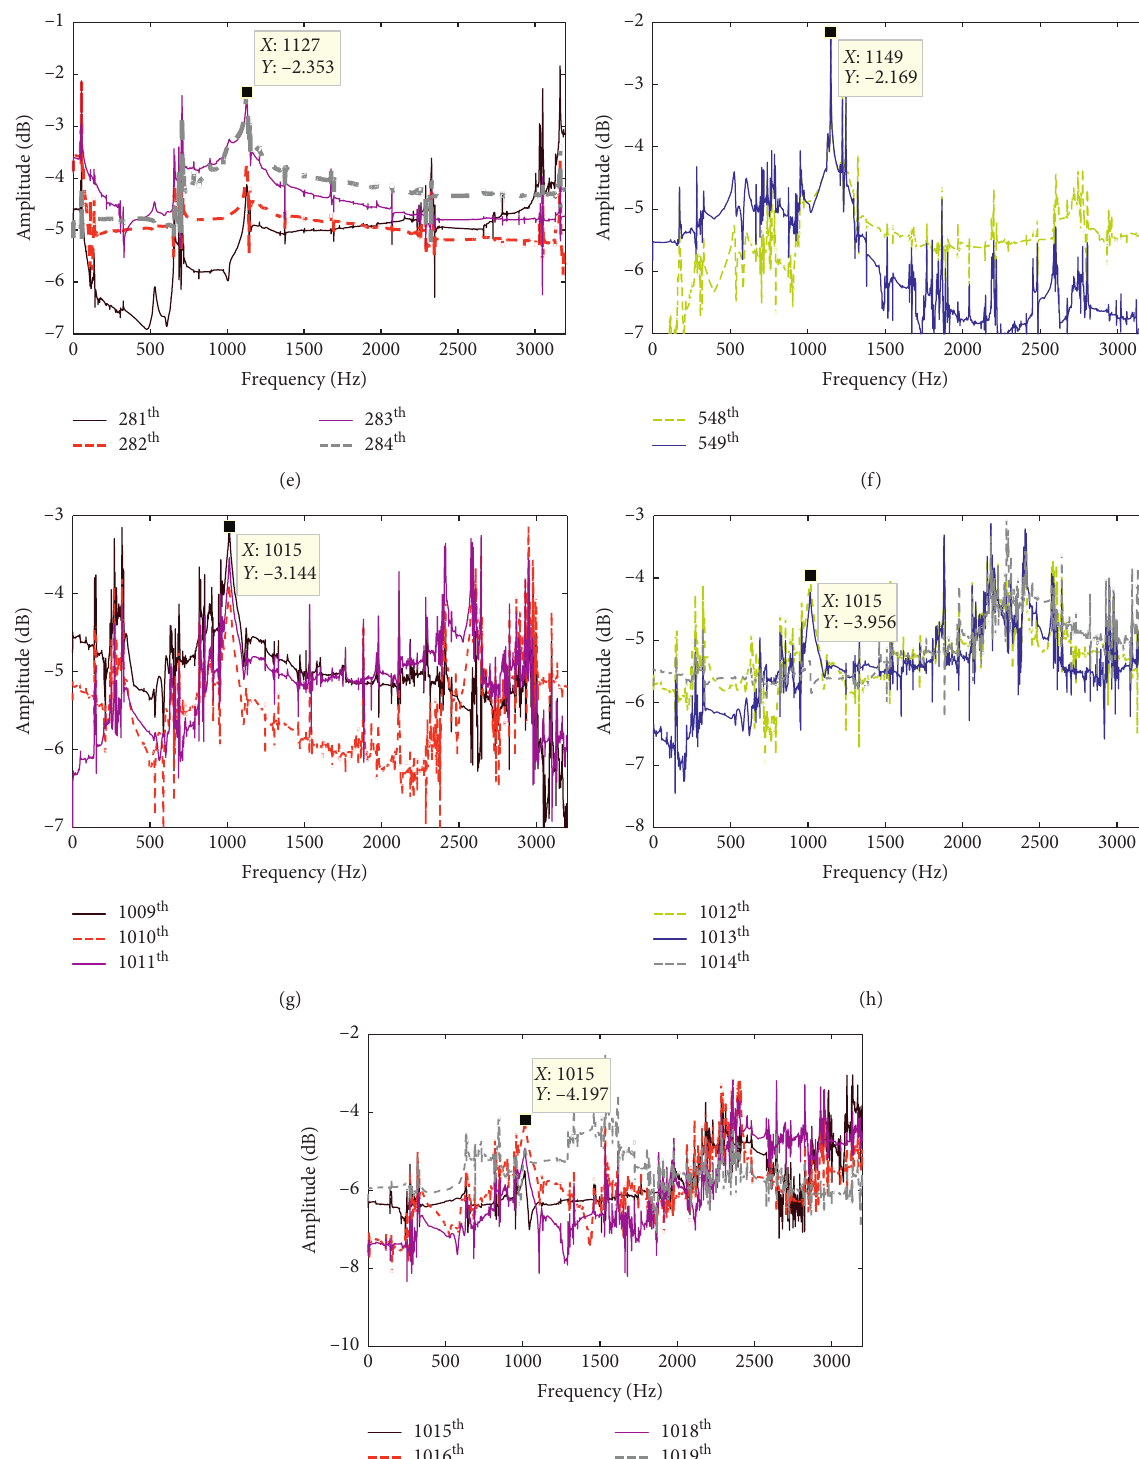
Figure 16: Component signals of noise modes at 1014, 1127, and 1149Hz. (a) Component signals 78, 80, and 81. (b) Component signals 79, 80, and 81. (c) Component signals 275, 276, and 277. (d) Component signals 278, 279, and 280. (e) Component signals 281, 282, 283, and 284. (f) Component signals 548 and 549. (g) Component signals 1009, 1010, and 1011. (h) Component signals 1012, 1013, and 1014. (i) Component signals 1015, 1016, 1018, and